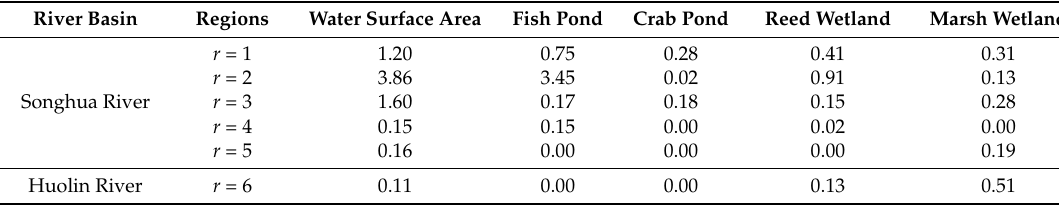
Table 2. The initial planned water supplement area of different ecosystems by the interconnected river system network project in western Jilin Province (10 4